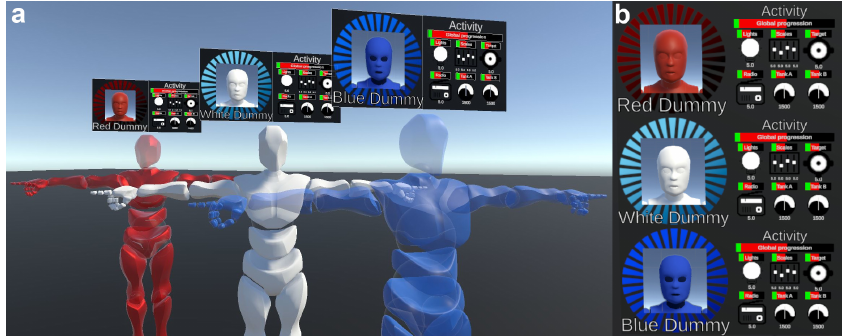
Figure 3. Workspace situated placement: ( a ) distributive placement—each panel is attached relative to the user it refers to; ( b ) aggregative placement—all information is gathered on the same panel.